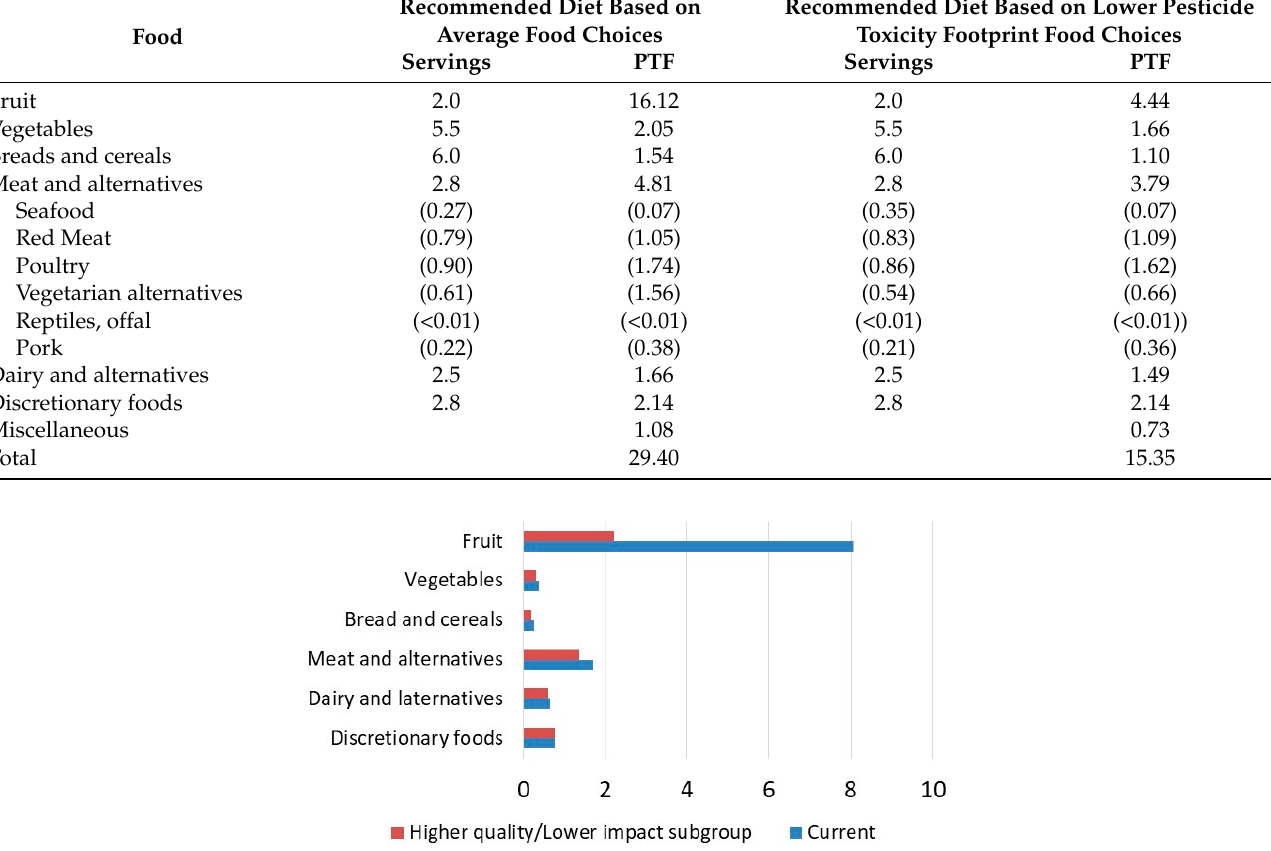
Table 3. Food intake (servings person − 1 ) and pesticide toxicity footprint (PTF, points per person − 1 ) for recommended diets for 19–50-year-old Australian adults. Recommended diets are based on the food choices evident in the current average diet ( n = 5175) and the lower pesticide toxicity footprint subgroup ( n = 1677) identified by the quadrant analysis. See the text for details. Food groups are as defined by the Australian Dietary Guidelines.